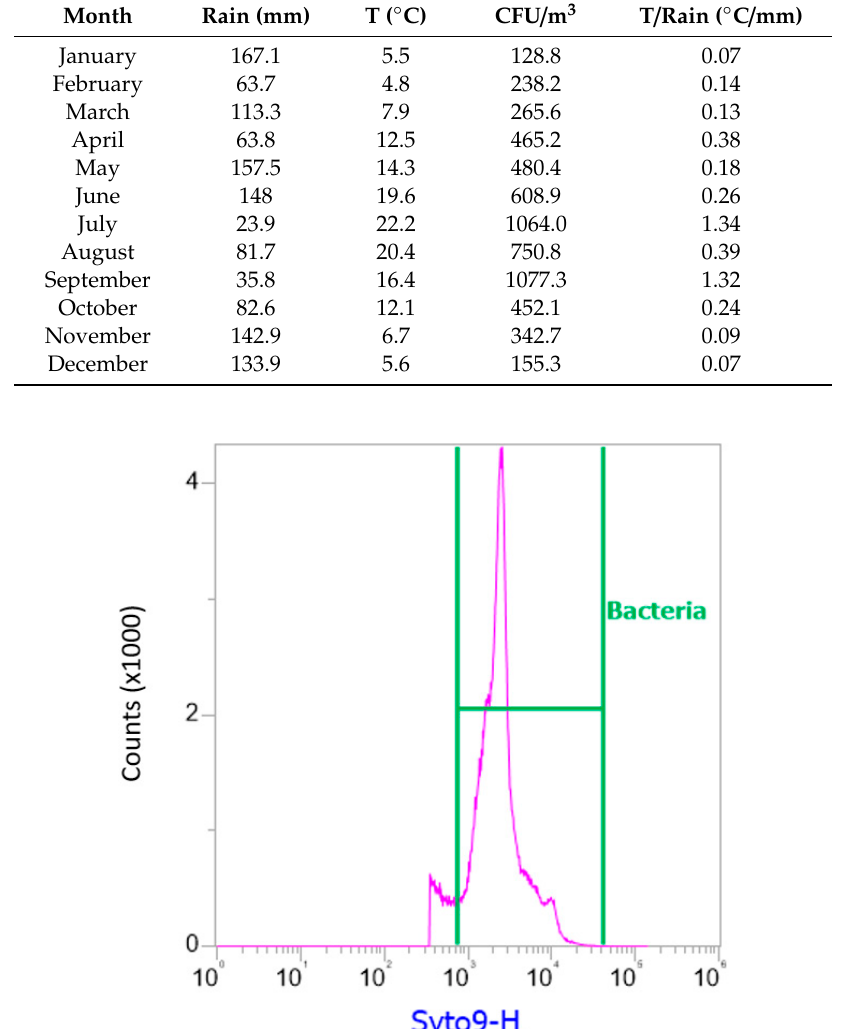
Table A2. Monthly means of Rain (mm), Temperature (°C) and sum of cultivable bacteria (CFU/m 3 )